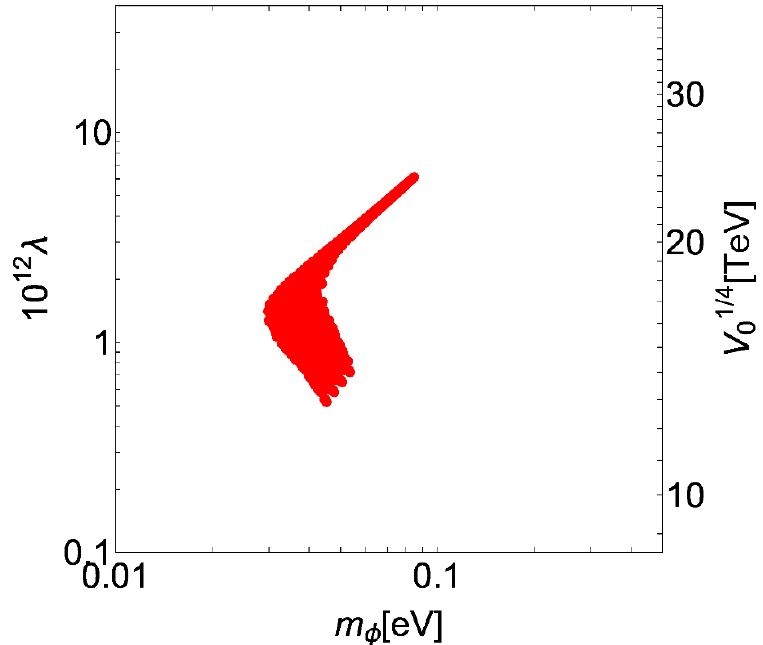
Figure 2 . The range of m (cid:30) and (cid:21) with f = 10 7 GeV. The points are consistent with the CMB observation at more than 95%